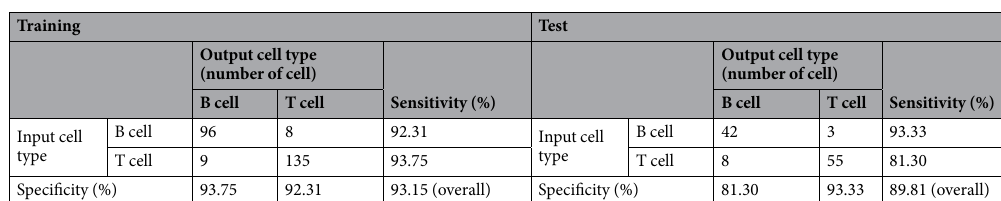
Table 1. Detailed performance of the B and T lymphocyte cell type classifiers. The identification accuracy and its sub-parameters, sensitivity and specificity, were also presented.